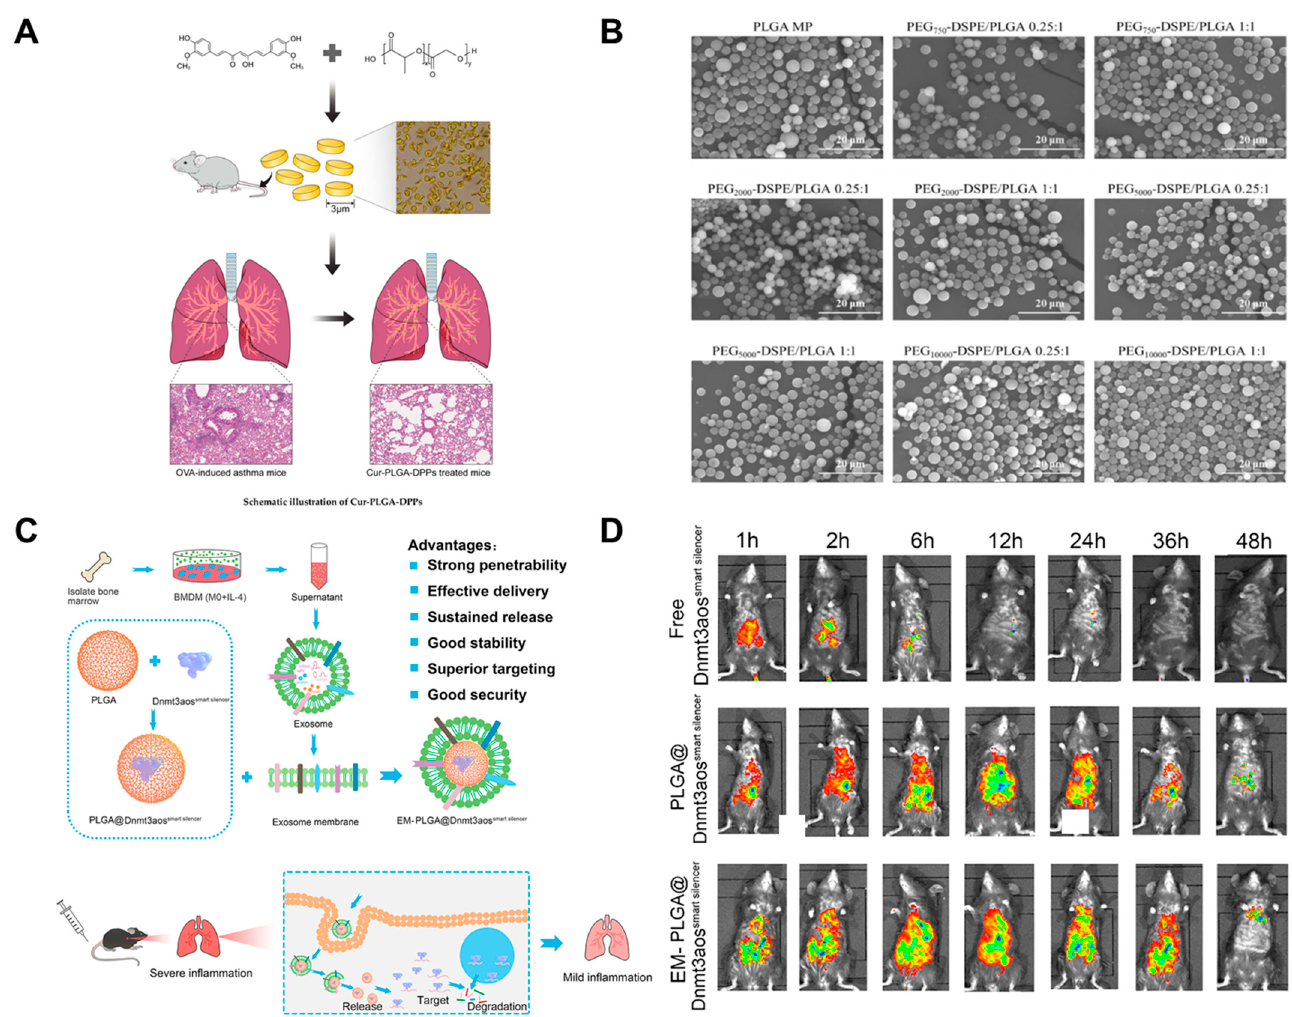
Figure 2. ( A ) Therapeutic efficacy of curcumin enhanced by microscale discoidal polymeric particles in a murine asthma model. Reproduced with permission from [110]. ( B ) Morphology of the